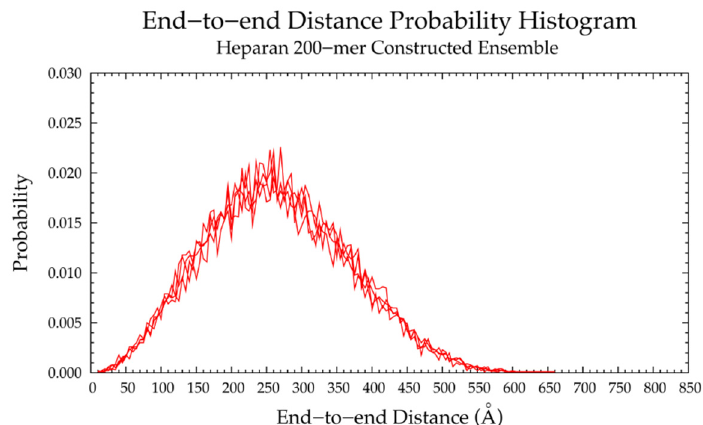
Figure 23. End-to-end distance probability distribution of constructed ensemble of nonsulfated heparan 200-mer; most probable end-to-end distance across all four sets is 260 Å; probabilities were calculated for end-to-end distances sorted into 5 Å bins; the ensemble contains four sets of 10,000 conformations.